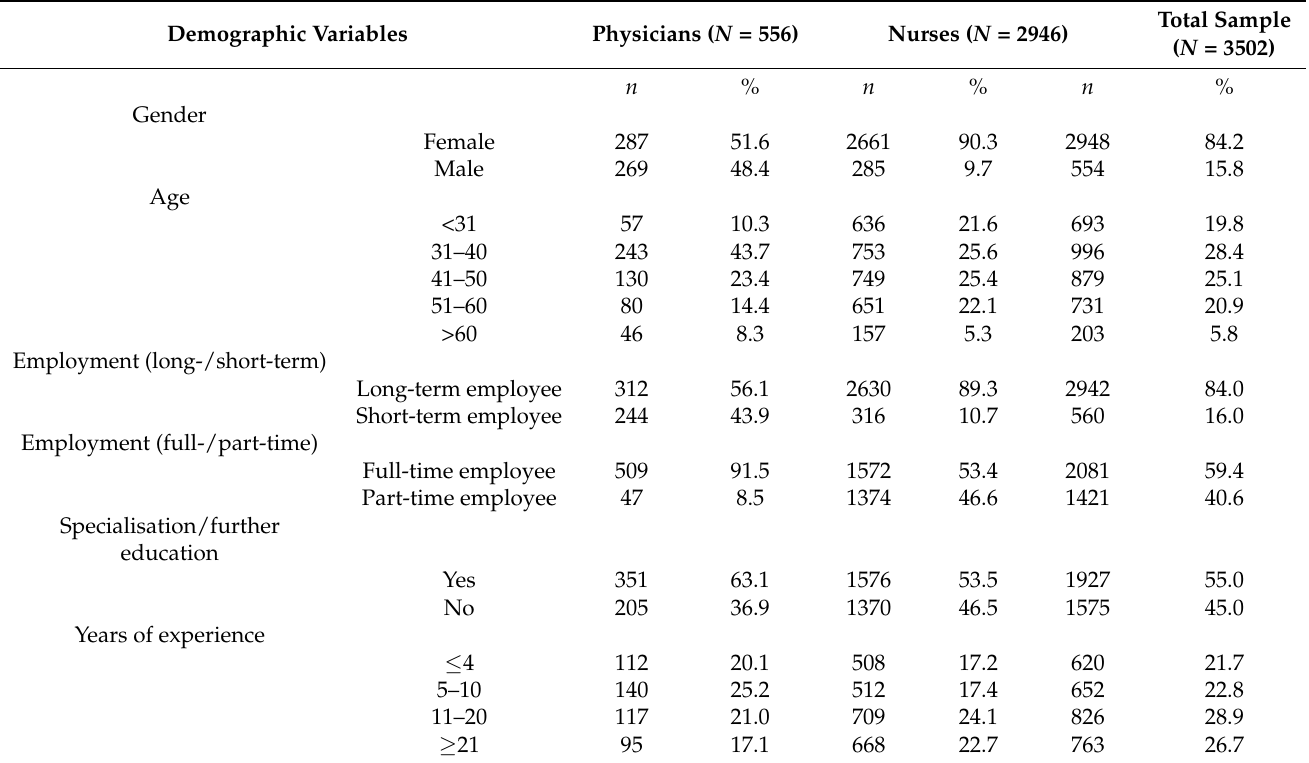
Table 1. Participants in the